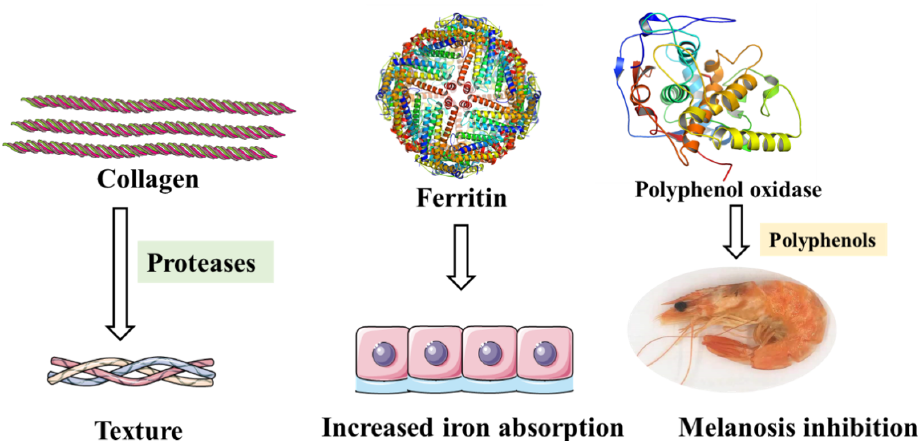
Figure 6. Specific proteins in fishery products that contributed to the texture, color, and